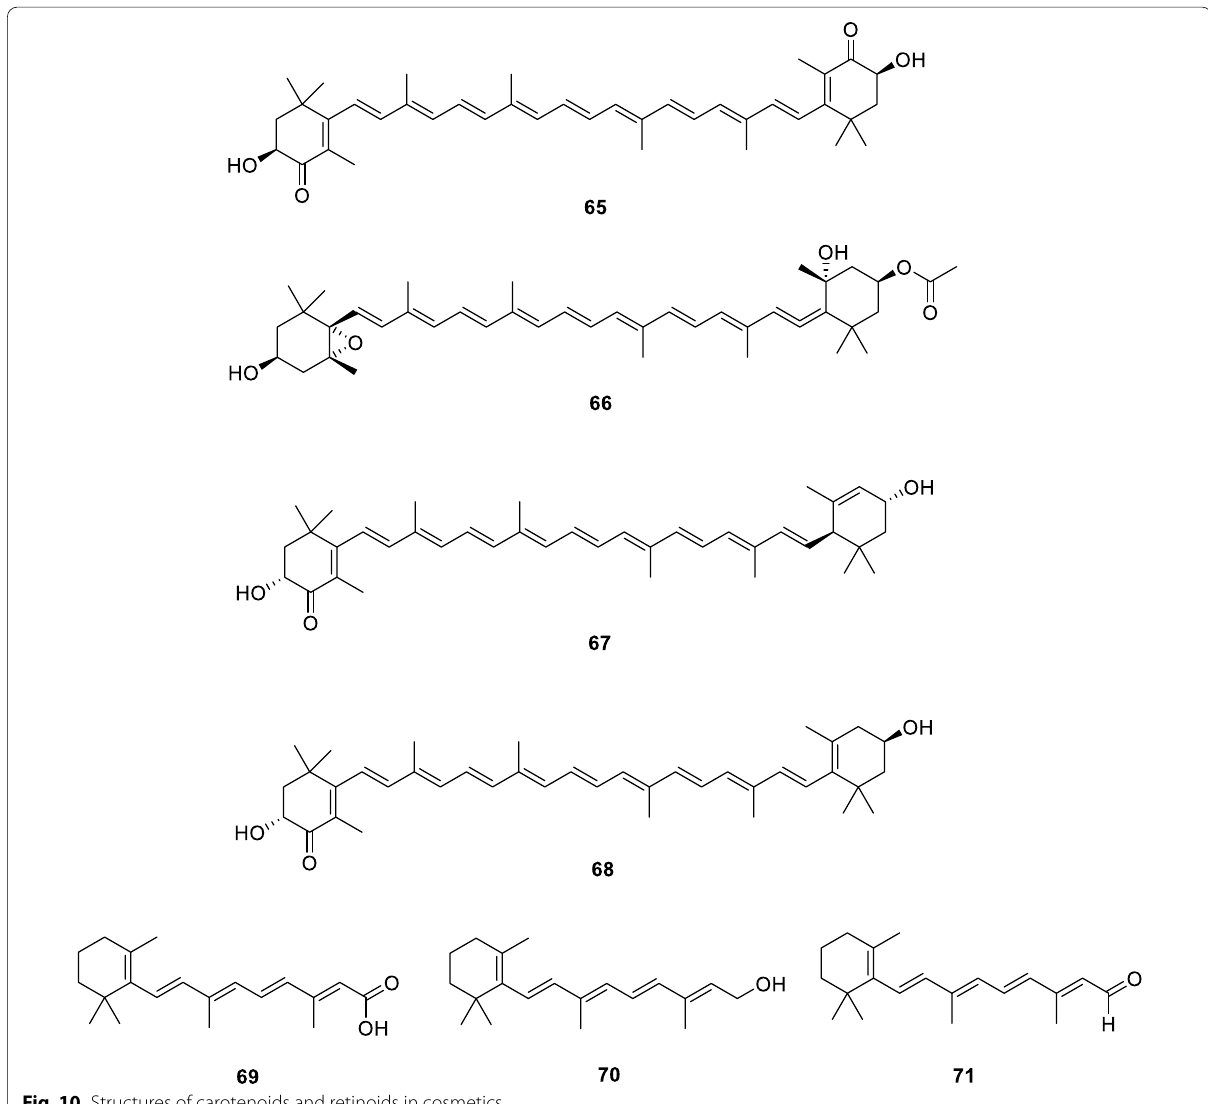
Fig. 10 Structures of carotenoids and retinoids in